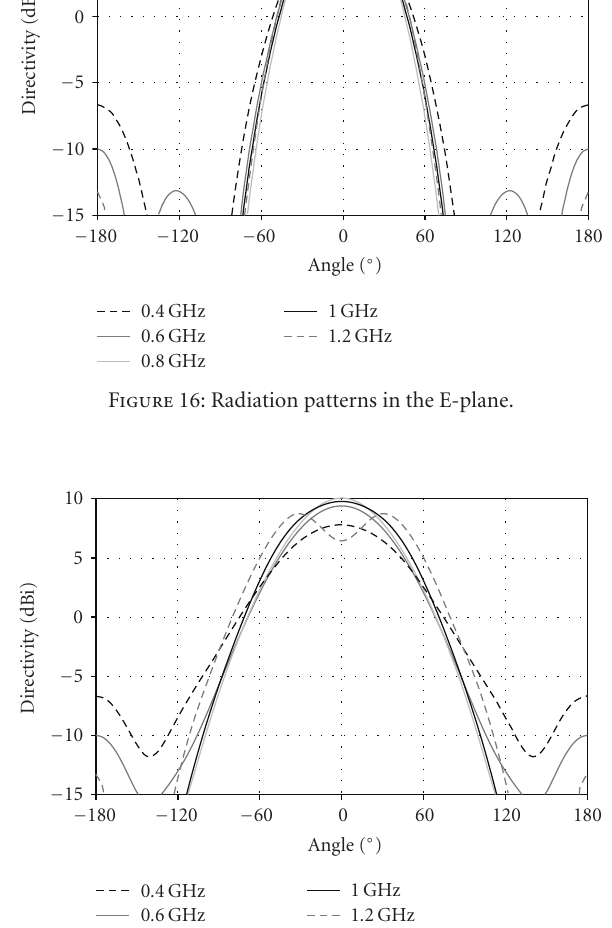
Figure 20: Antenna matching versus the dipole location.